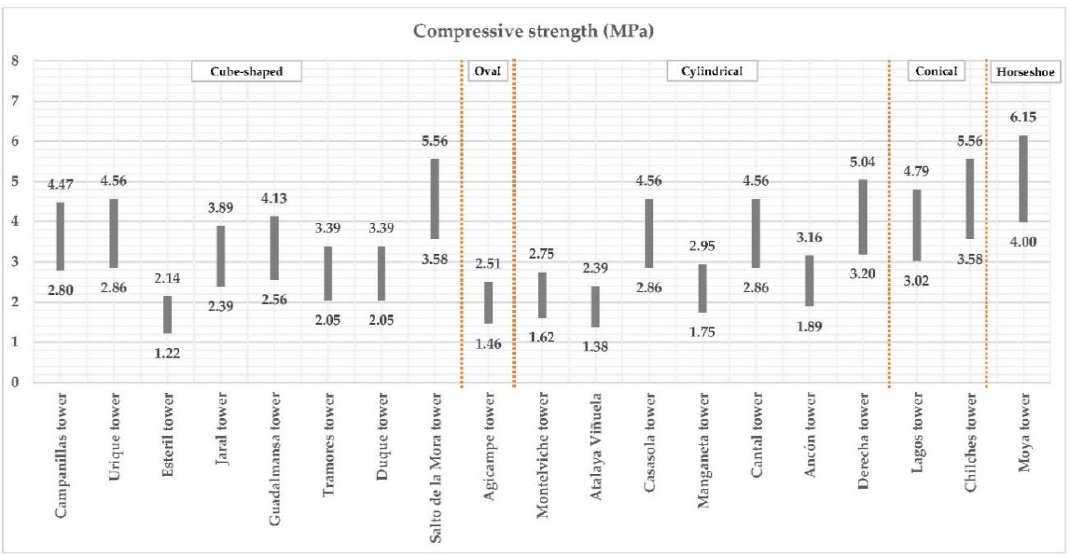
Figure 17. Compressive strength of the masonry (f m ).